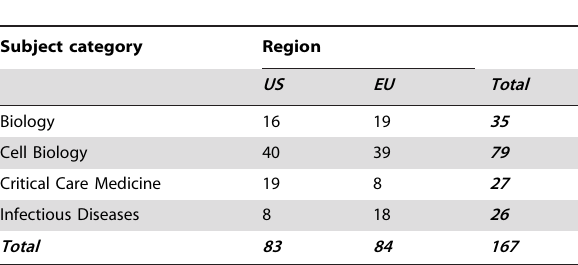
Table 1. Distribution of the journals included in our analysis according to region and subject